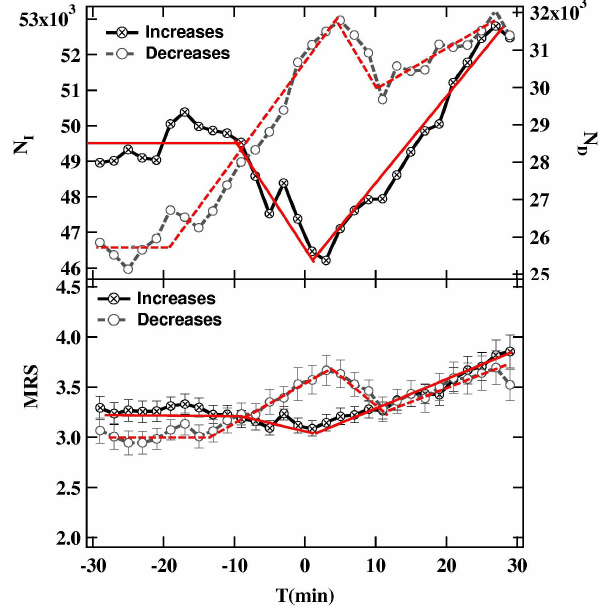
Fig. 4. The upper panel shows the number of echoes vs. time for Increases (114 events, black curve, N I , left axis) and Decreases (64 events, grey curve, N D , right axis). The lower panel shows MRS vs. time for I (black curve) and D (grey curve) events. The red lines superimposed on the curves highlight the main